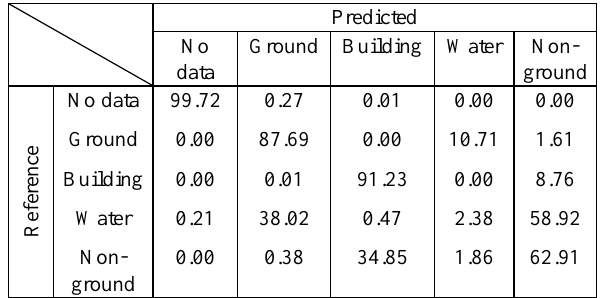
Table 4. Confusion matrix of ALS train